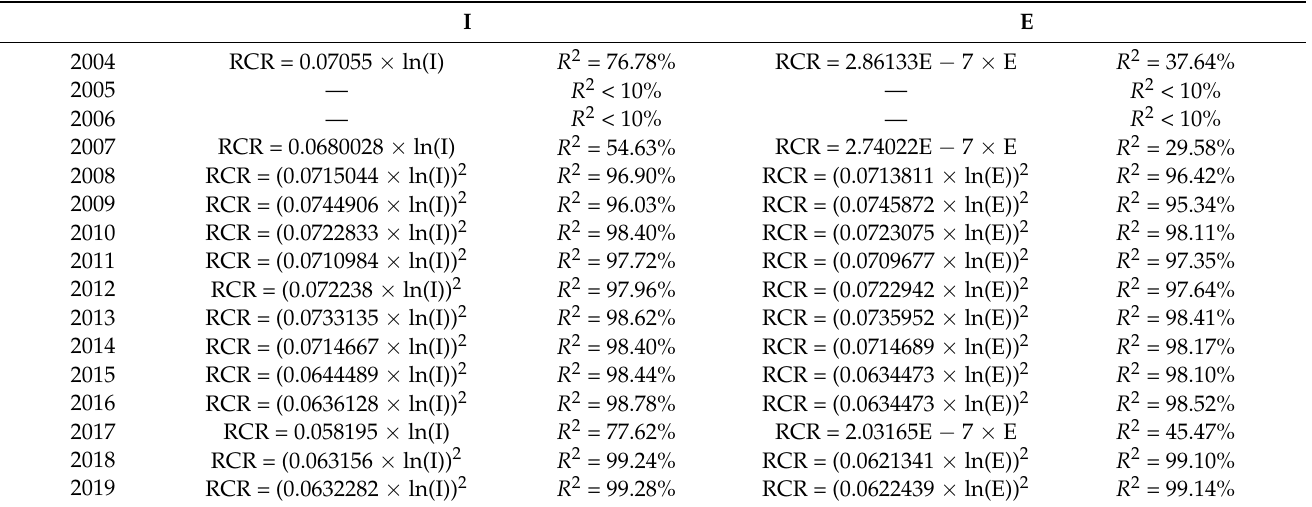
Table 3. Regression functions of the relationship of the RCR index with income/expenditure in the years 2004–2019